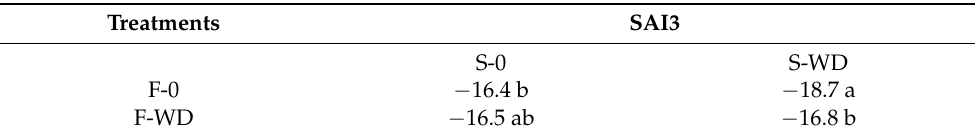
Table 4. Soil alteration index (SAI3) as affected by the interaction of wood distillate (WD) distribution as foliar spray (F) and soil irrigation (S). Data are means of three replicates ( n = 3). Same letters indicate not significantly different means at p ≤ 0.05, Tukey test.